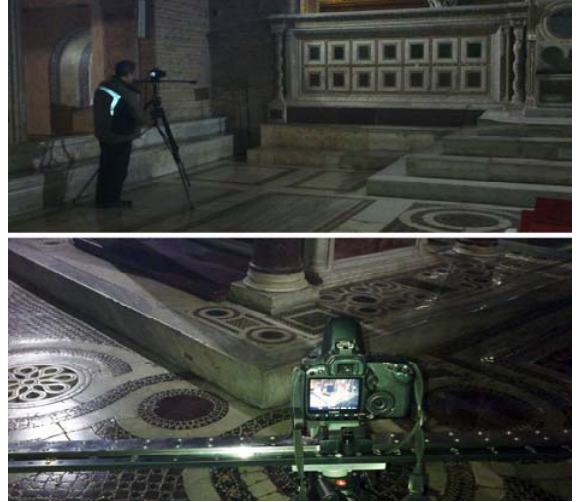
Figure 5. The images of acquisition technique with Menci  POST-PROCESSING PHASE: CRITERIA AND OPERATING